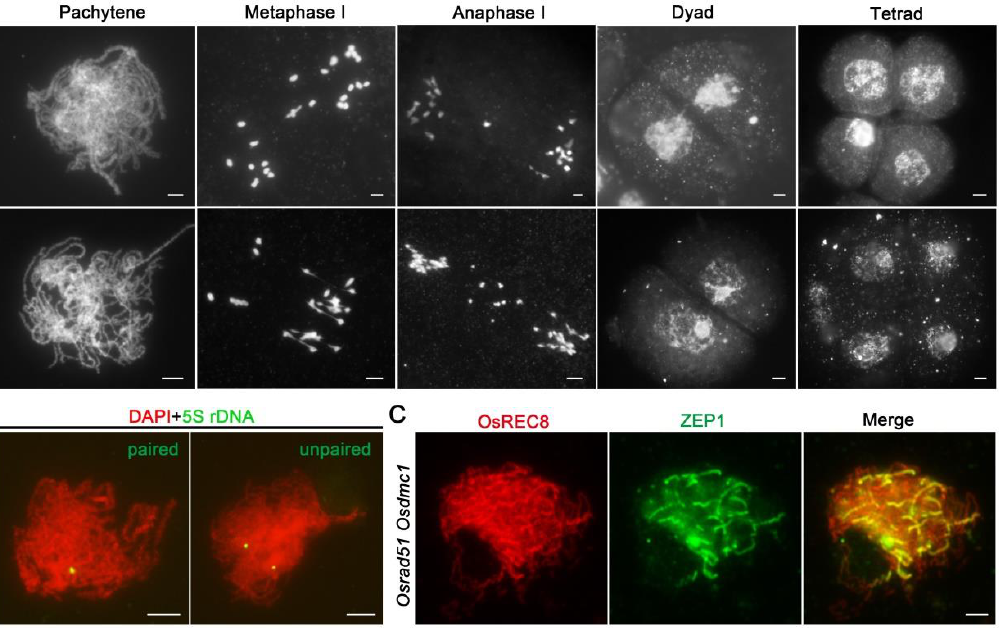
Figure 7. Genetic analysis of Osrad51 with Osdmc1 . ( A ). Meiotic chromosome behavior in the Osrad51 Osdmc1 double mutant PMCs. ( B ). The chromosome pairing status in Osrad51 Osdmc1 . The painting probe was 5S rDNA. Chromosomes were stained with DAPI (red). Left panel, the Osrad51 Osdmc1 PMCs show paired probe signals; right panel, the Osrad51 PMCs show unpaired probe signals. ( C ). Immunostaining for a transverse filament protein of the SC (ZEP1, green) in the Osrad51 Osdmc1 double mutant at pachytene. OsREC8 signals (red) show the chromosomes. Bars, 5 μ m.